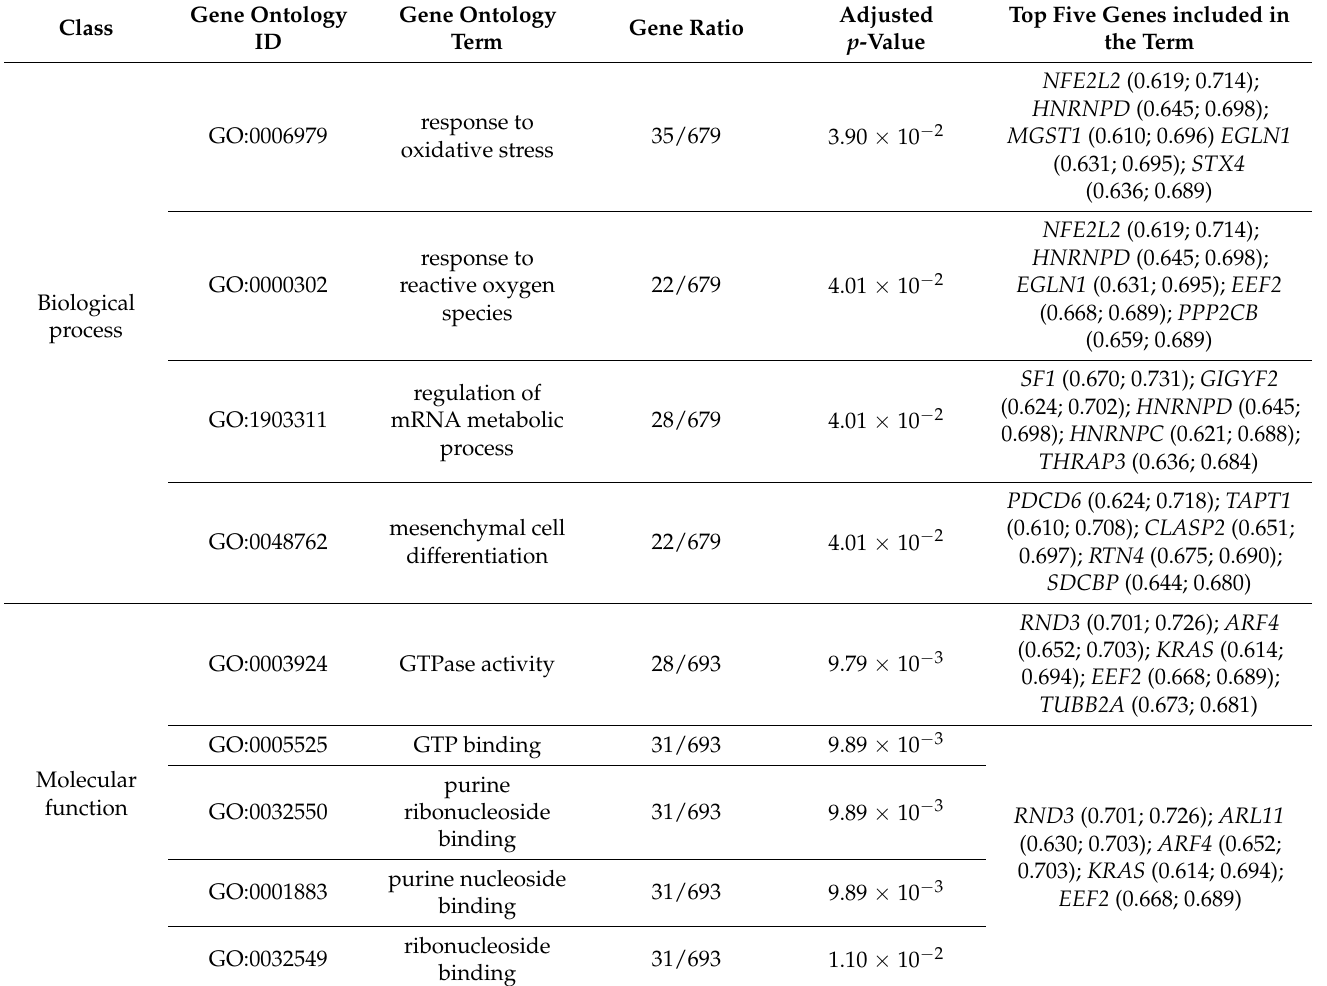
Table 4. Result of the functional gene annotations of the new biomarker candidates identified in in vitro and validated human samples. The table shows only the top five genes in terms. The first value is the ROC AUC in vitro, and the second value is the ROC AUC in human